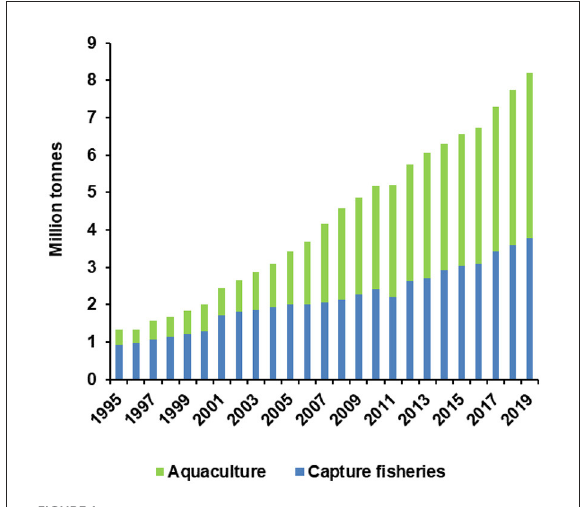
FIGURE1 Aquaculture and capture fisheries production in Vietnam, 1995–2019. Data source: Directorate of Fisheries (2017, 2018, 2019), and General Statistics Office